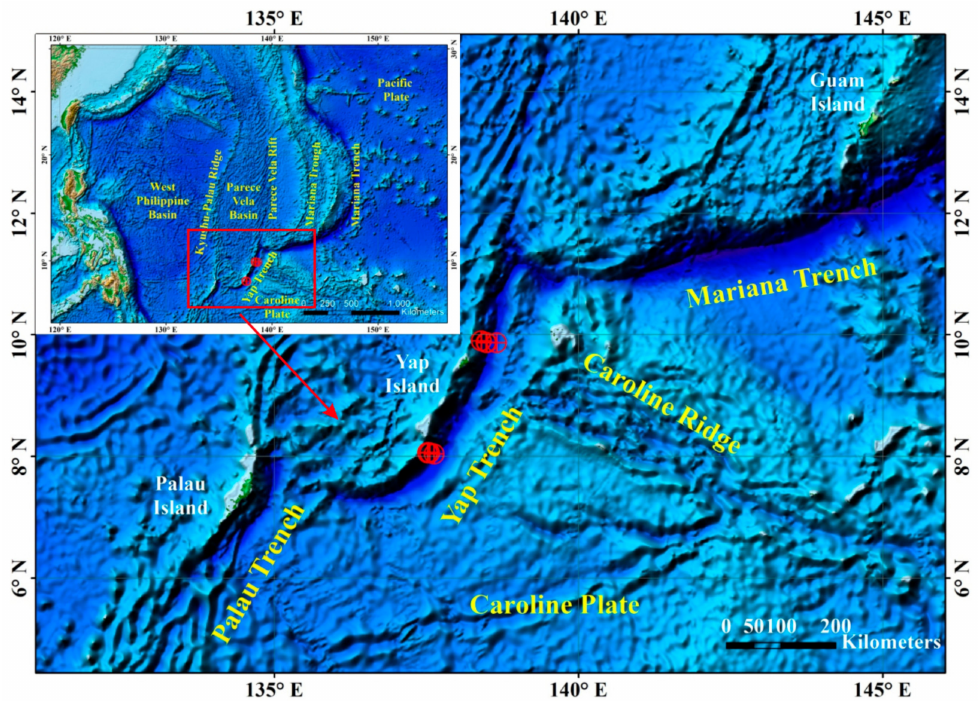
Figure 1. Bathymetry and tectonic features of the studied area. Red box shows the location of the Yap Trench. Sampling locations (red circles) for Dive 112 (northern Yap Trench) and JL 149 (southern Yap Trench) are